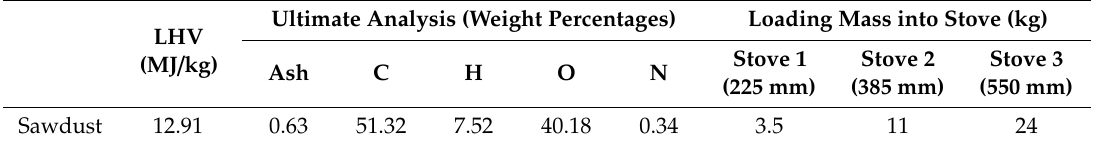
Table 1. Sawdust properties and loading mass into each